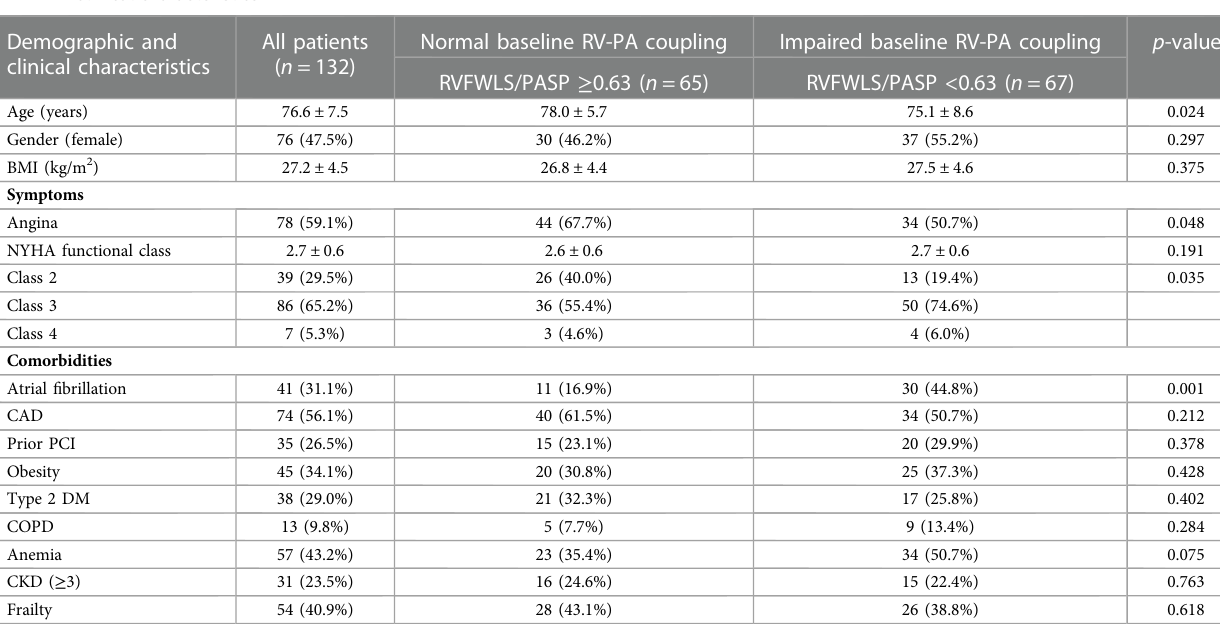
TABLE 1 Clinical characteristics.